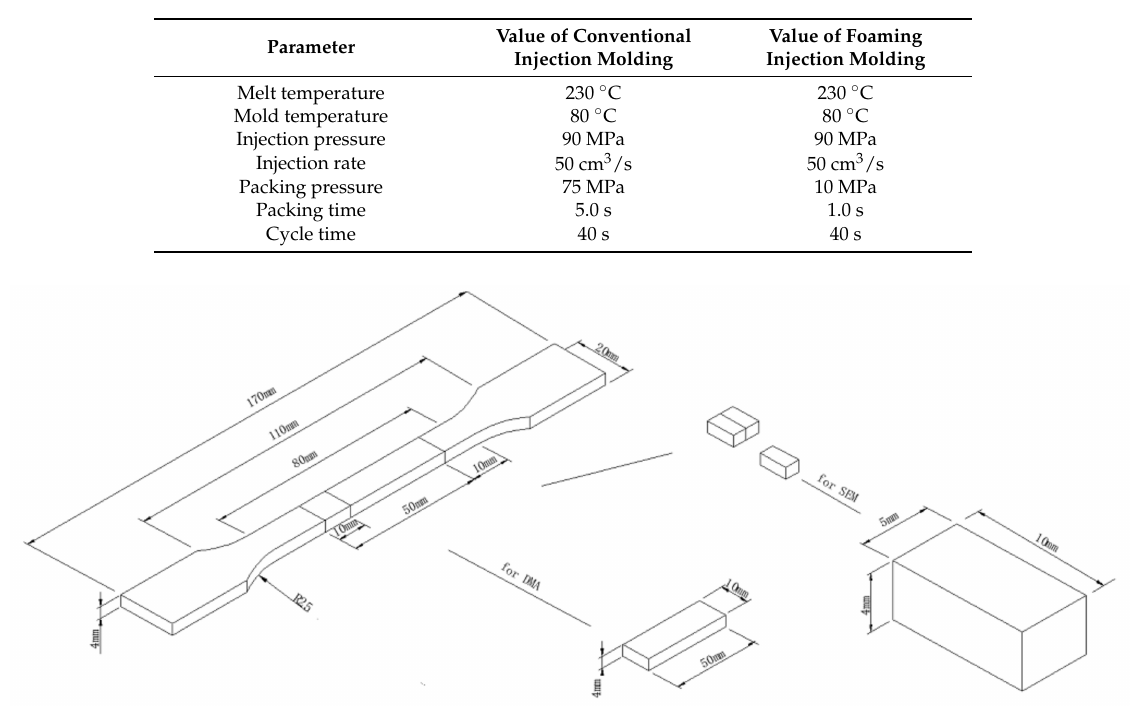
Figure 2. A detailed description of sample size and